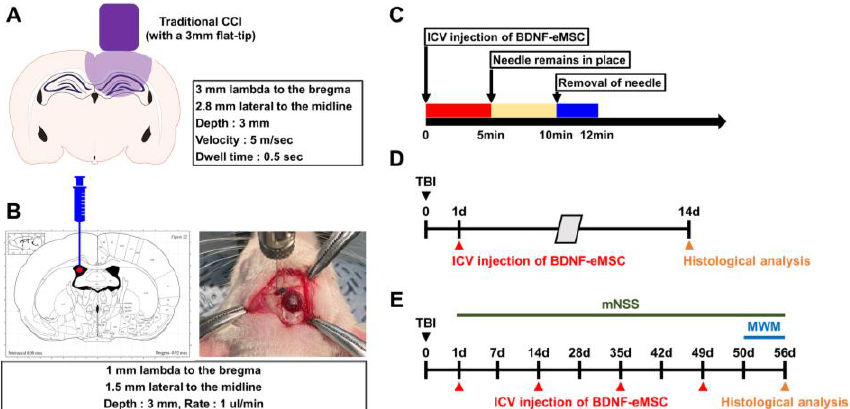
Figure 3. Schematic information of in vivo TBI experiments. ( A ) Schematic diagram of experimental condition for TBI using controlled cortical impact (CCI) device. ( B , C ) Method of intracerebroventricular injection of BDNF-eMSCs. BDNF-eMSCs were injected into the lateral ventricle region of the rat brain 24 h after TBI. ( D , E ) Timeline showing the experimental design of the sub-acute phase for 14 days ( D ) and the chronic phase for 56 days ( E ) post-TBI.